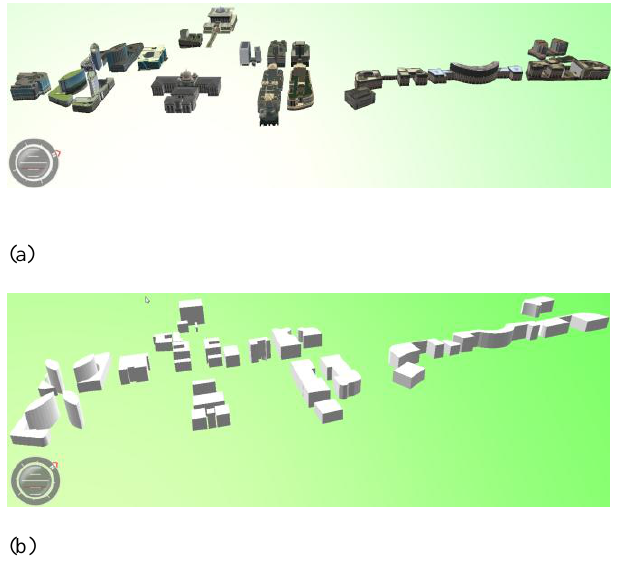
Figure 6. Original 3D building models of Putrajaya city of Malaysia (a) and simplified models at LoD1